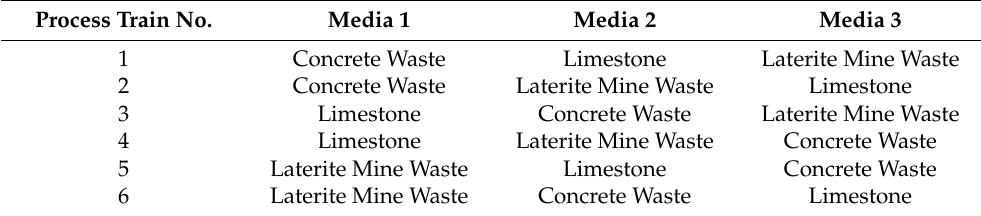
Table 3. Process train configurations.